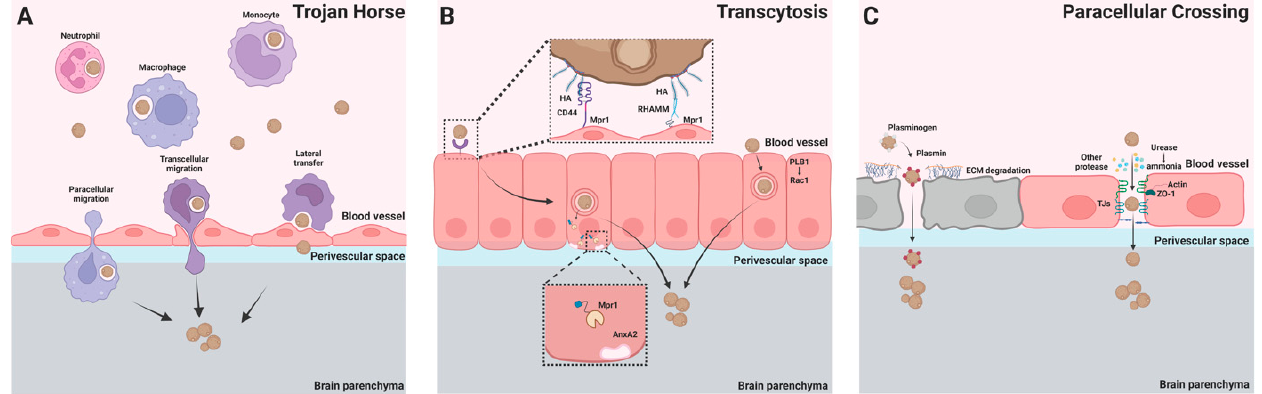
Figure 1. C. neoformans’ transmigration to the brain across the BBB. Three pathways have been proposed for the BBB crossing of C. neoformans . ( A ) Trojan horse. Phagocytes can carry ingested C. neoformans across the BBB through paracellular and transcellular migration. Phagocytes containing C. neoformans can also directly transfer the fungal cell to brain endothelial cells through lateral transfer, leading to BBB crossing of the organism. ( B ) Transcytosis. Interactions of cryptococcal hyaluronic acid with endothelial CD44 or receptor of hyaluronan-mediated motility (RHAMM) lead to endocytosis of the yeast cell. Following endocytosis, cryptococcal Mpr1 interacts with Annexin A2 (AnxA2) to facilitate exocytosis of the organism from the endothelial cells. In addition, cryptococcal phospholipase B1 (PLB1) promotes transcytosis through activation of host cell Rac1. ( C ) Paracellular crossing. Host plasminogen (white) binds to C. neoformans and is converted to the serine protease plasmin (red). Plasmin degrades the extracellular matrix (ECM), facilitating fungal crossing of the BBB. The tight junction of the BBB can be damaged by cryptococcal urease (due to the toxic effects of urease-induced ammonia) and other secreted cryptococcal proteases. C. neoformans can invade the brain across the damaged BBB.